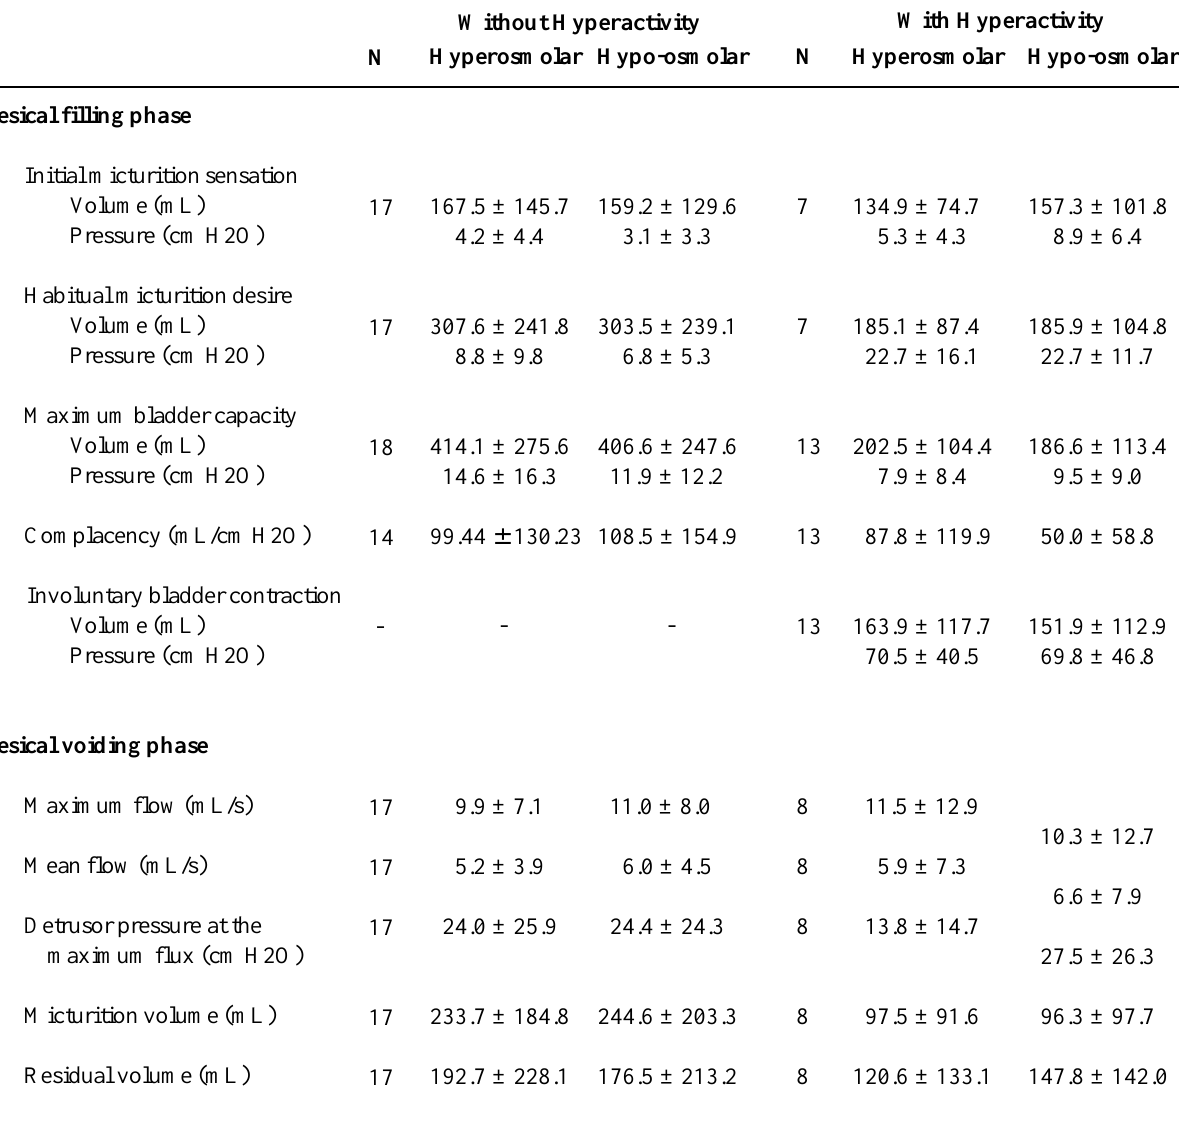
Table 4 – Values of urodynamic variables when vesical filling is accomplished with hyper- and hypo-osmolar solutions in patients with and without vesical hyperactivity (mean ± standard